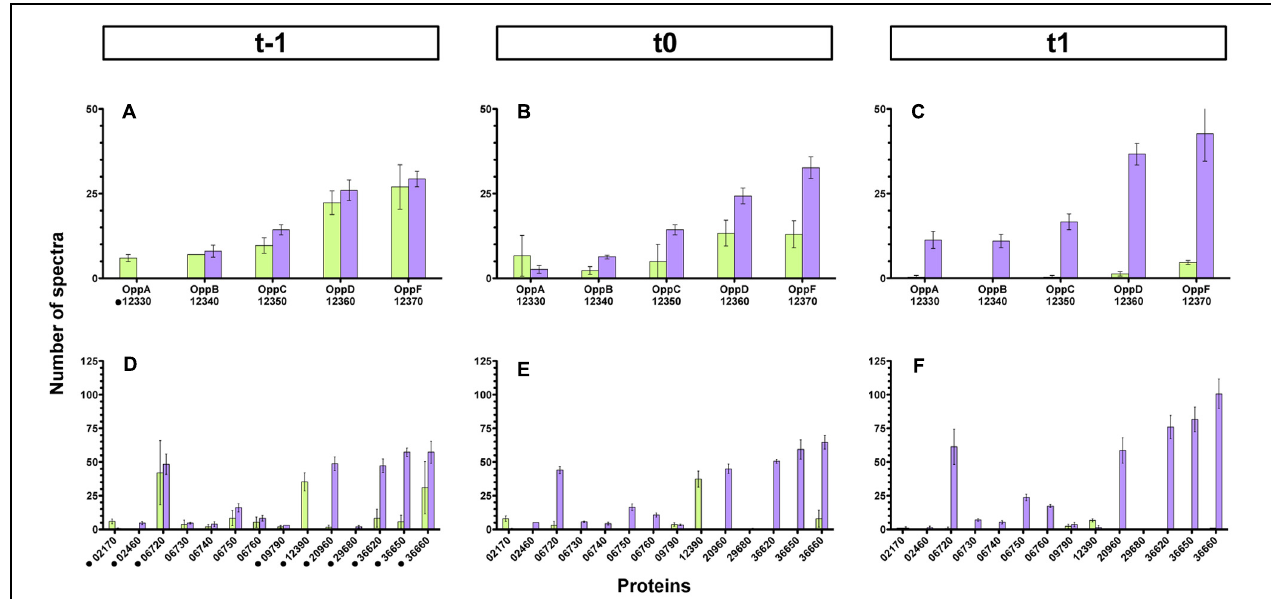
FIGURE 8 | Detection of Opp-like proteins in membrane-enriched fractions from (cid:2) codY and wild-type cells. Membrane-enriched fractions obtained from (cid:2) codY and wild-type cells harvested 1 h before (t-1, A,D ), at (t0, B,E ), or 1 h after (t1, C,F ) the transition into stationary phase were analyzed using mass spectrometry. The histograms represent the number of spectra detected in the samples for each protein indicated on the x-axis. The upper panels report the data for the components of the oligopeptide permease Opp of which the pore is required for PapR import. The lower panels report the data for the other Opp-like proteins detected. The results are the mean values of three independent experiments, and the error bars represent standard deviations. The black dots in (A,D) indicate an OppA-like protein. Purple bars, wild-type samples; green bars, (cid:2) codY